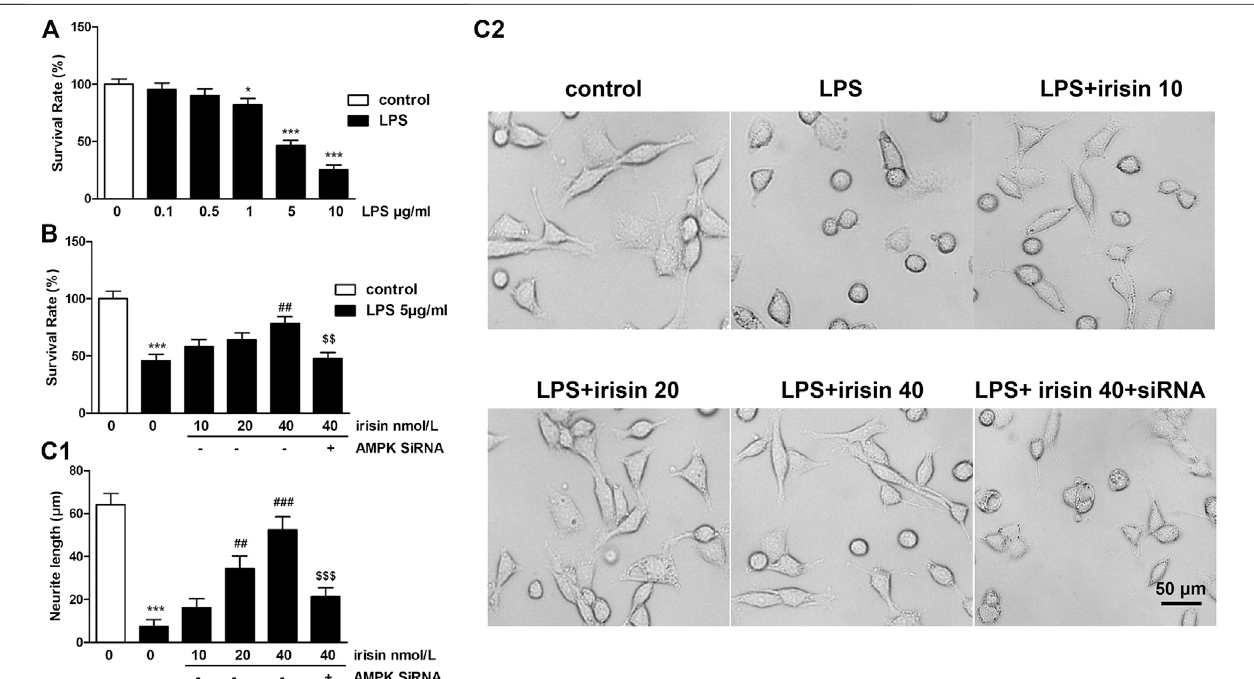
FIGURE 4 | (A) Survival rates of PC12 cells challenged with different doses of lipopolysaccharide (LPS) ( p (cid:2) 0.000015 for 5 μ g/ml LPS group). (B) Effects of irisin (doseof10,20,40 nmol/L)onthesurvivalrateofPC12cellschallengedwith5 μ g/mlLPS(*** p (cid:2) 0.000072, ## p (cid:2) 0.0022, $$ p (cid:2) 0.003). (C1-2) NeuritelengthofP12cells treatedwithirisinfollowedby5 μ g/mlLPSpretreatment(*** p (cid:2) 0.000031, ### p (cid:2) 0.000052, $$$ p (cid:2) 0.00093).Scalebar (cid:2) 50 μ m.DataarepresentedasMean ± SEM,n